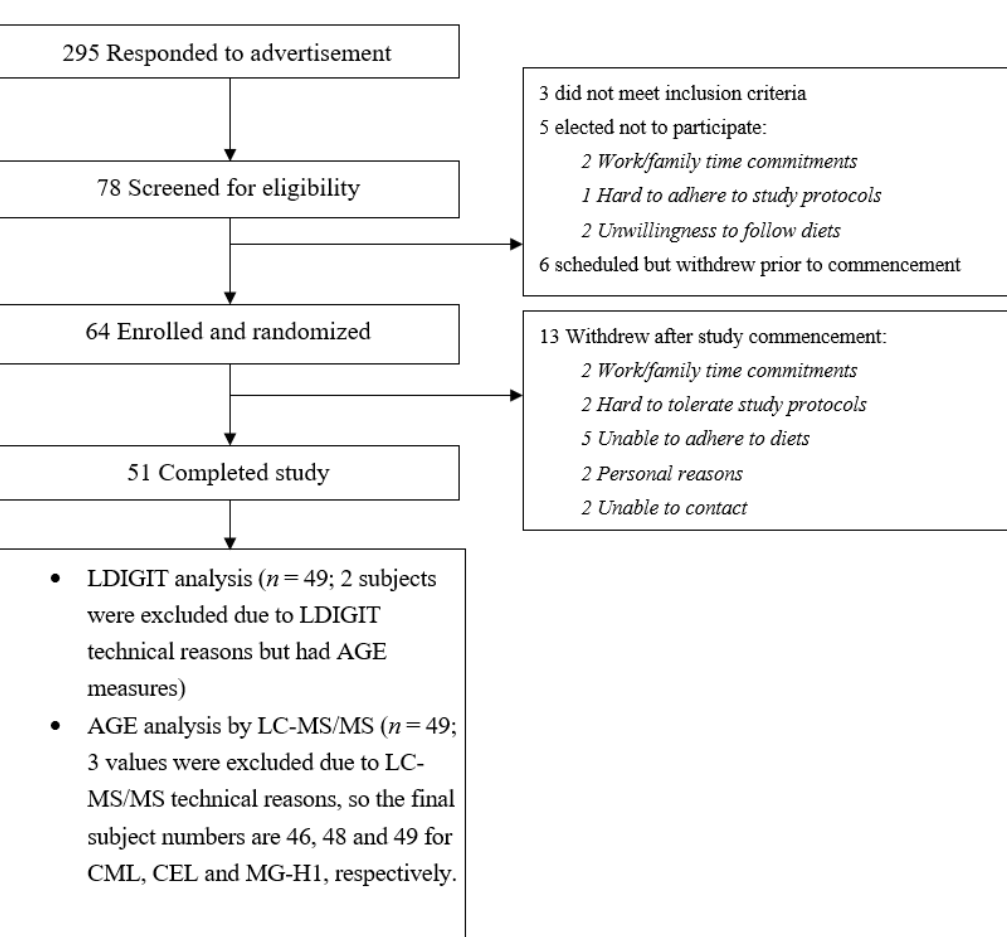
Figure 1. Flow diagram of subject recruitment and sample analysis explanation.